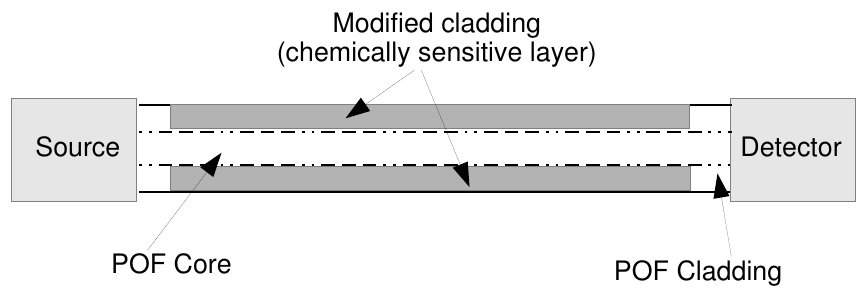
Figure 2. Configuration of the plastic optical fiber